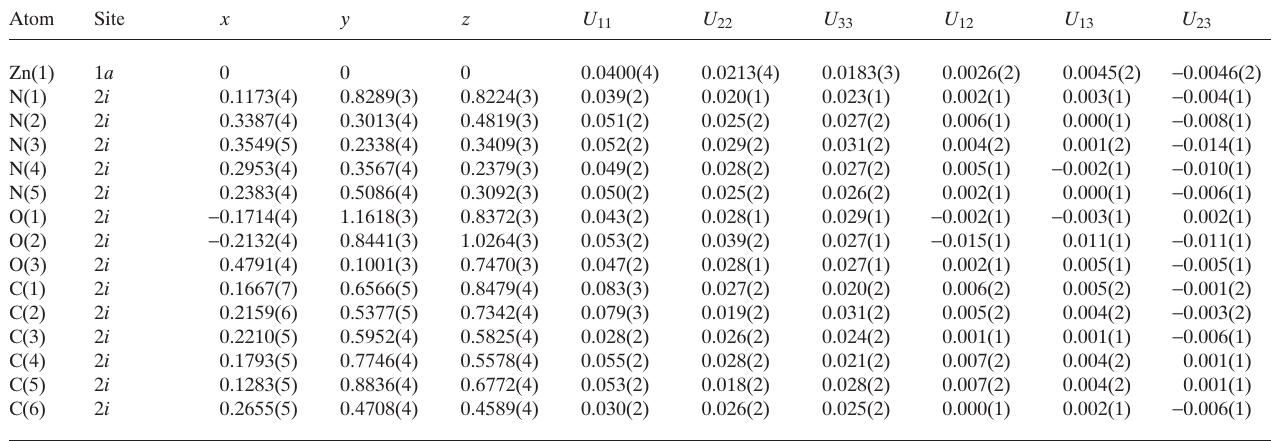
Table 3. Atomic coordinates and displacement parameters (in Å 2 ) .